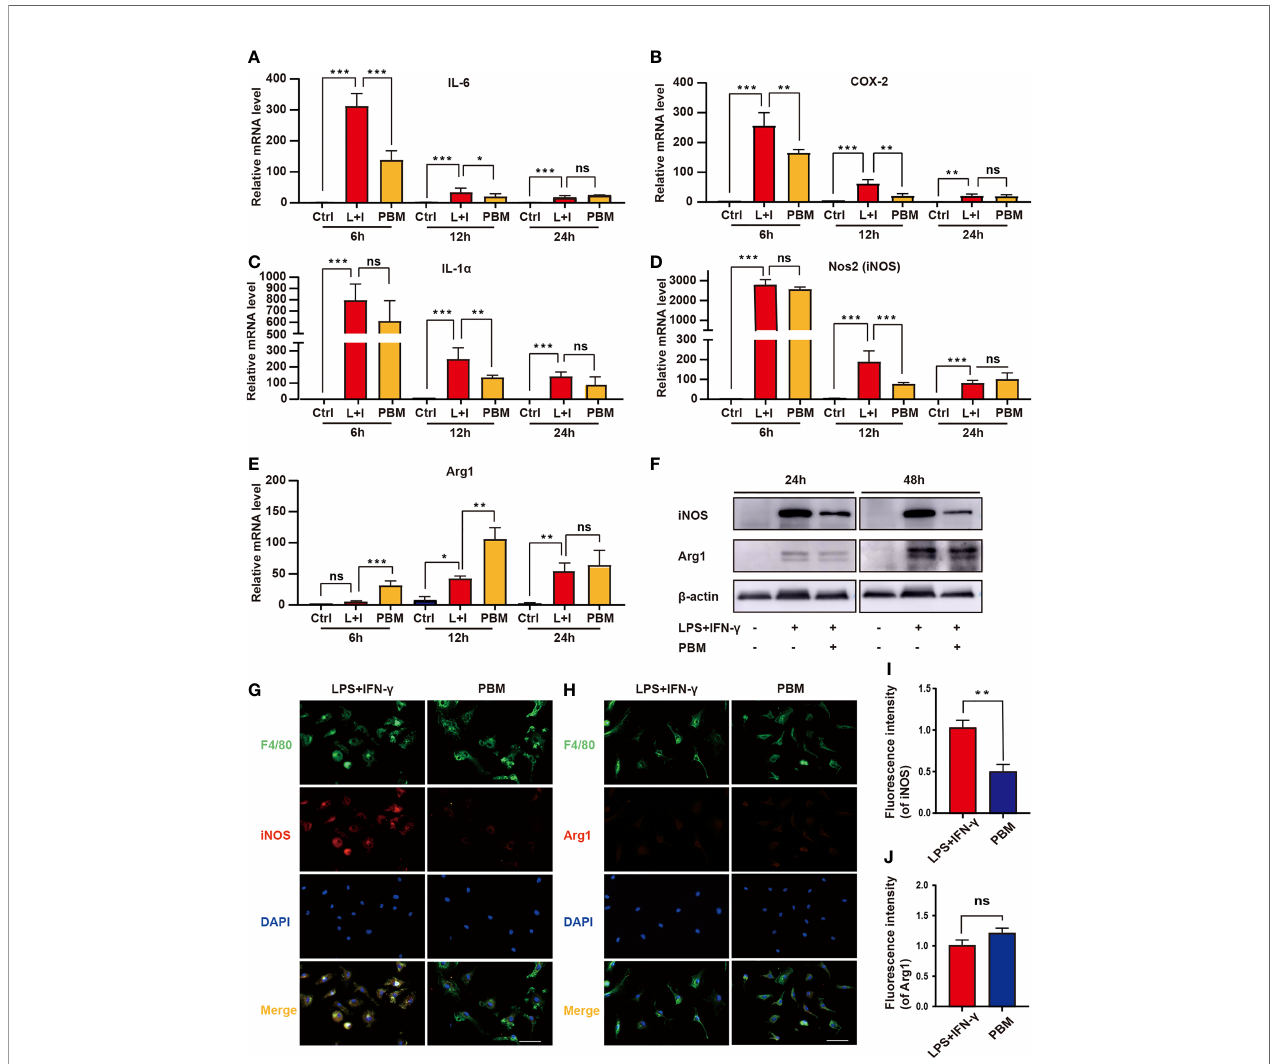
FIGURE 5 | In vitro validation of the regulation of in fl ammation-related genes by PBM. (A – E) The expression of M1-related genes (NOS2, IL-1 a , IL-6, and COX-2) and M2-related genes (Arg1) in the Ctrl (M0), L+I (LPS + IFN- g ), and PBM (LPS + IFN- g + PBM) groups was detected by RT – PCR at the 6th, 12th and 24th hours after PBM intervention (n = 3 per group). (F) Representative immunoblots of Arg1 (M2 macrophage marker) and iNOS (M1 macrophage marker) in the Ctrl (M0), L+I (LPS + IFN- g ), and PBM (LPS + IFN- g + PBM) groups at 24 and 48 hours after the fi rst PBM intervention (n = 3 per group). (G, I) Representative images of F4/80 (green), iNOS (red) and DAPI (blue) immuno fl uorescence staining in the LPS + IFN- g and PBM (LPS + IFN- g + PBM) groups (n = 3 per group). (H, J) Representative images of F4/80 (green), Arg1 (red), and DAPI (blue) immuno fl uorescence staining in the LPS + IFN- g and PBM (LPS + IFN- g + PBM) groups (n = 3 per group at each time point). *P < 0.05, **P < 0.01, ***P < 0.001; ns, not signi fi